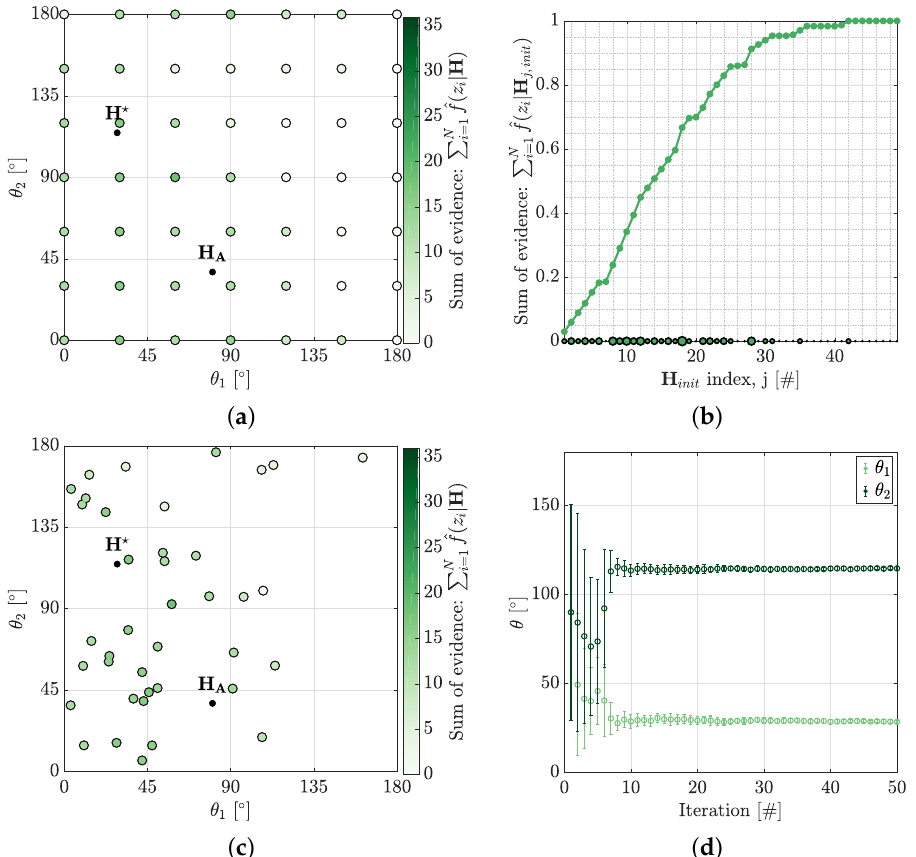
Figure 11. Convergence of the particle search method used to locate H (cid:63) . ( a ) The sum of evidence is determined for an initial set of hypotheses, H init . ( b ) A CDF is constructed from this initial measure to guide the concentration of the search for ( c ) the next set of hypotheses, H next . ( d ) The solution for this example is shown to converge to H (cid:63) in approximately 10 iterations of this process, error bars indicate 1 σ of the particle